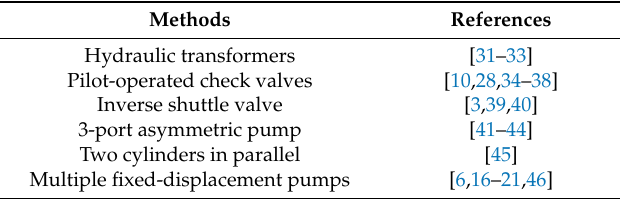
Table 1. Methods for compensating the differential